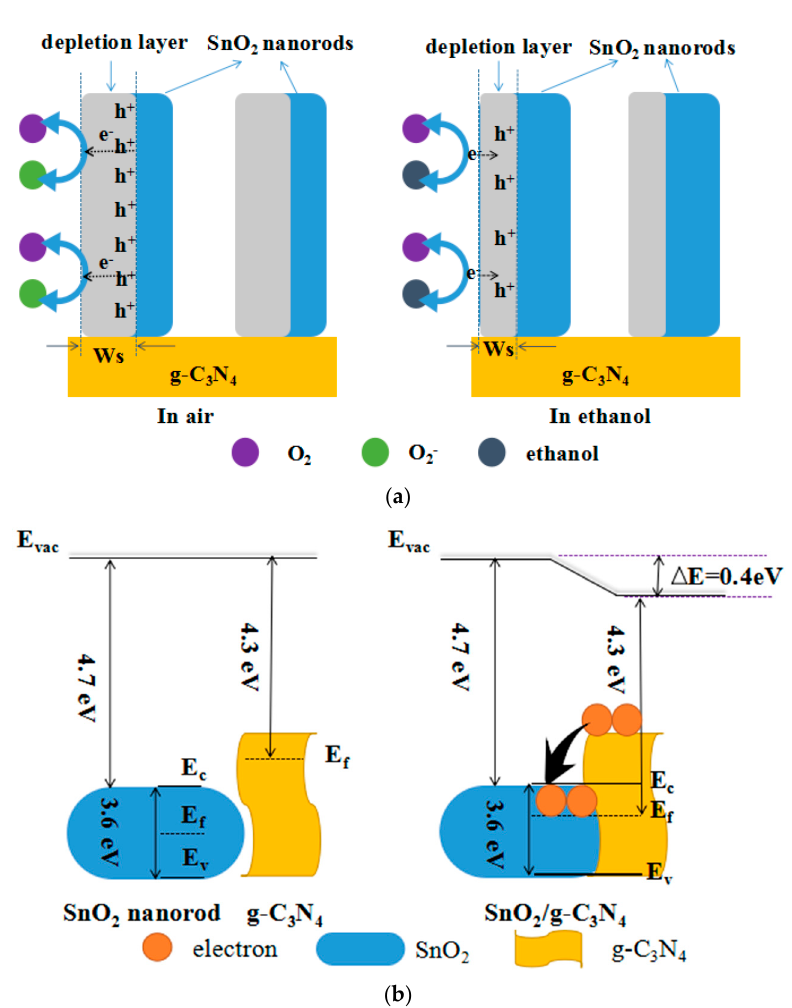
Figure 10. ( a ) The schematic diagram of air and ethanol react with the synthesized composite; and ( b ) the band diagram of SnO 2 /g-C 3 N 4 before and after the combination.